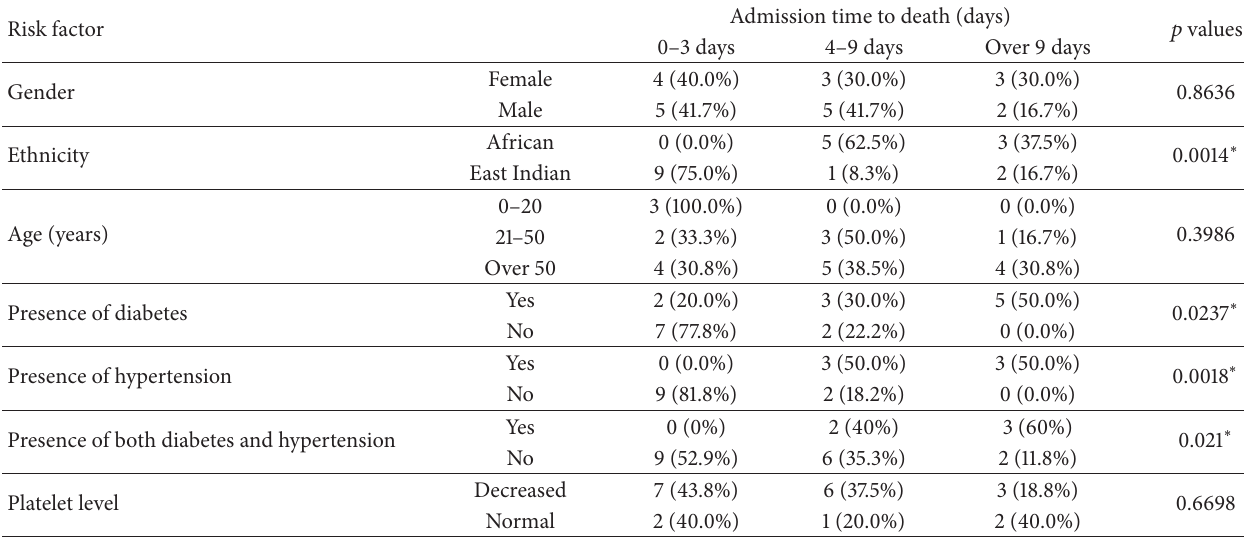
Table 1: Admission time to death (days) versus risk